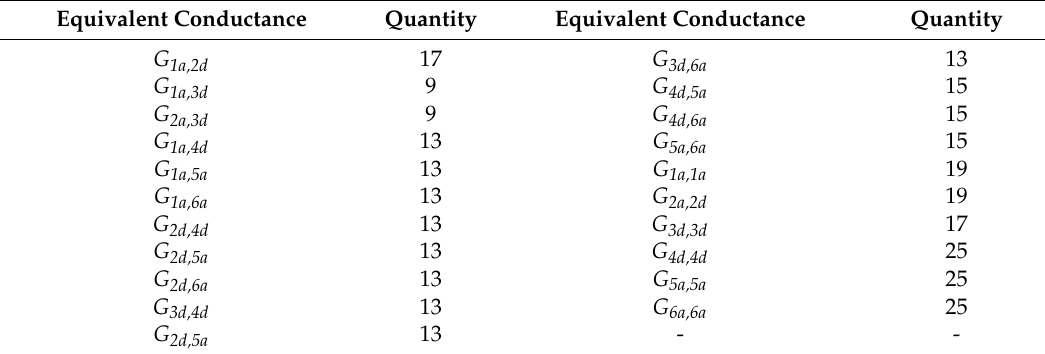
Table 1. The number of equivalent conductance.